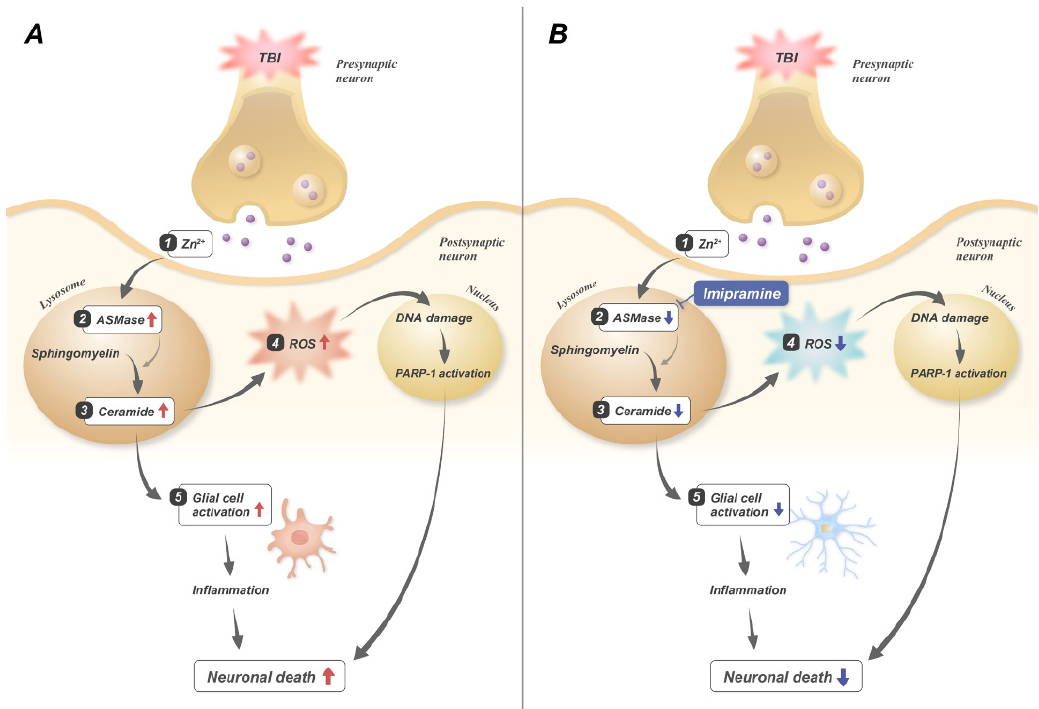
Figure 6. Hypothetical connections between imipramine and TBI-induced neuronal death. ( A ) TBI-induced neuronal death mechanism; (1) under TBI condition, excessive zinc relation and translocation occur; (2) excessive zinc induces overactivation of ASMase; (3) abnormal ASMase activation increases excessive ceramide production; (4) excessive ceramide increases ROS production; (5) increased ceramide induces glial activation. Finally, neuronal death abnormally occurs in hippocampus. ( B ) Imipramine treatment reduces neuronal death by inhibiting ASMase in lysosomes. Imipramine decreases ASMase activation and ceramide formation, after which ROS and glial cell activation are also reduced. Therefore, neuronal death decreases in hippocampus after TBI.